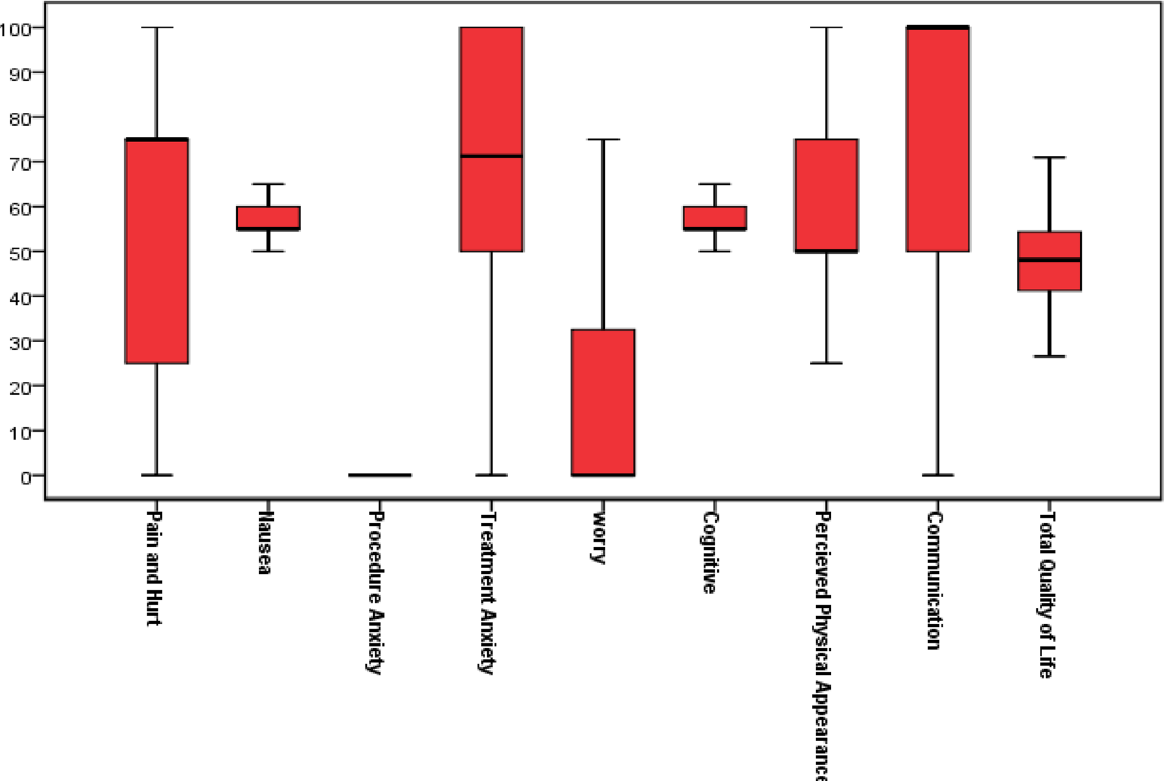
Fig. 2 Distribution of the overall quality-of-life scores and its domains in pediatric cancer patients